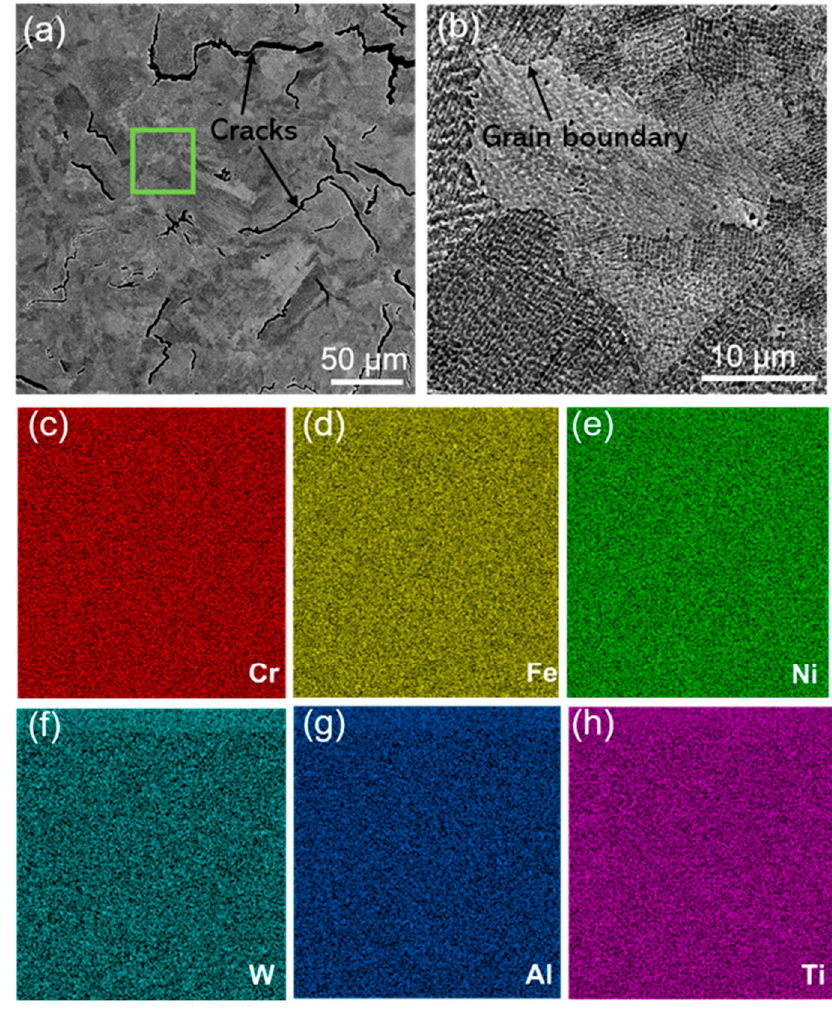
Figure 4. ( a ) Microstructure of SLM K213 alloy. ( b ) Local magnified area of the green box in ( a ). ( c – h ) Distribution maps of corresponding main components.